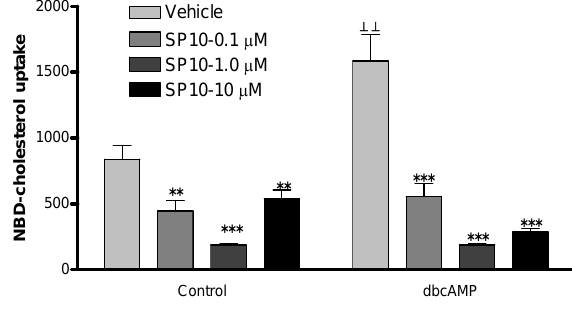
Figure 7. Effect of SP-10 on NBD-cholesterol uptake. Y-1 cells were incubated with the indicated concentrations of SP-10 for 48 h. Culture media were then changed, and cultures were incubated with 1mM dbcAMP and 1  g/ml NBD-cholesterol for 24 h. NBD- cholesterol uptake was measured by a Vector 2 multilable counter equipped with 485 nm excitation and 535 nm emission filters. Total fluorescence values were normalized to cellular protein. Results are presented as mean ± SD (n = 12 for each group). (** p < 0.01, *** p < 0.001 versus vehicle-treated group, ┴┴ p < 0.01 versus vehicle-treated control group, ANOVA followed by Scheffe F test).